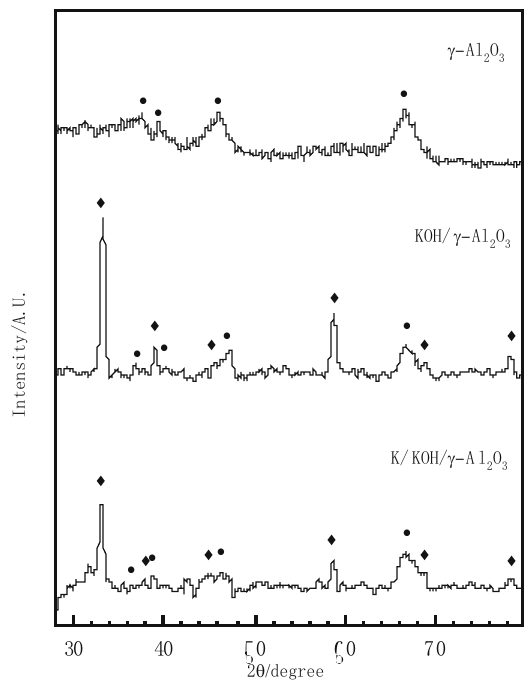
Figure 4: XRD patterns of samples: (cid:129) γ - Al 2 O 3 , ♦ β - KAlO 2